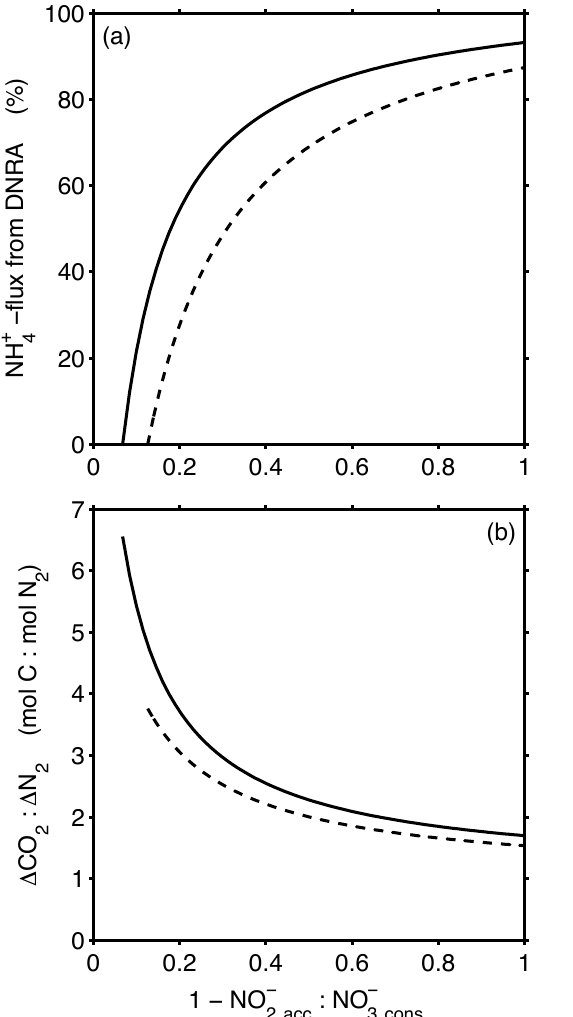
Fig. 5. Scenario I and II. Solid lines are for bulk organic matter composition, dashed lines for proteins. (a) The ratio of phosphate Fig. 4. Scenario II, assuming that suboxic N-conversions are due to released per N 2 formed. (b) The molar ratio of N 2 − N released to a combination of DNRN, DNRA, and anammox. We assume that nitrate used during no NH + , but variable fractions of NO − accumulate (see description 4 2 of x-axes in legend of Fig. 1). Solid lines are for bulk standard organic matter, dashed lines for proteins. (a) Percent fraction of NH + supply to the anammox reaction from DNRA. (b) 1 CO 2 : 1 4 N 2 ratio for scenario II.